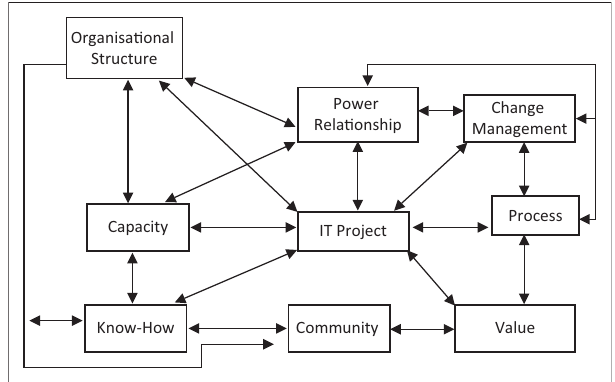
FIGURE 3: Dualism of information technology project